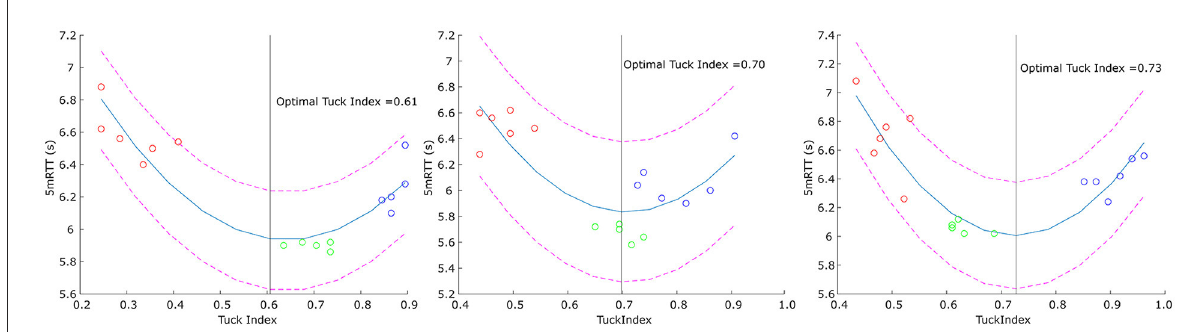
FIGURE4 Prediction of the optimal Tuck Index for three selected swimmers. Red circles: Close condition trials, green circles: Reference condition trials, blue circles: Far condition trials. Pink dashed lines: 95 % prediction interval, black line: optimal Tuck Index.